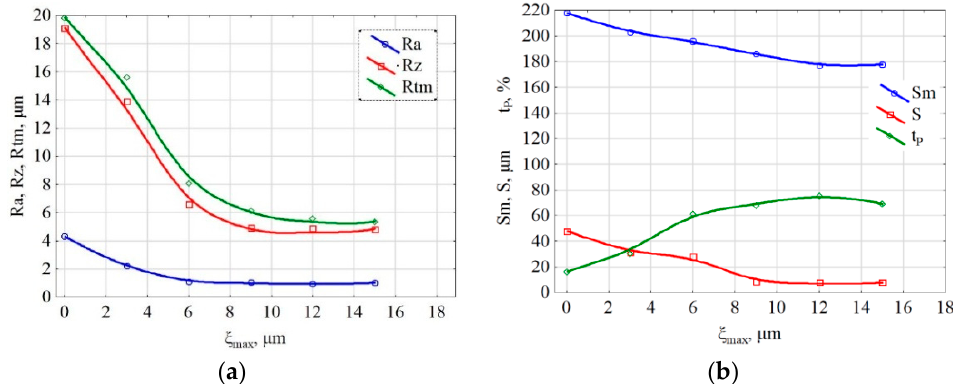
Figure 7. Functions of changes in height Ra, Rz, Rtm ( a ) and stepSm, S, tp ( b ) roughness parameters on the emitter oscillation amplitude.